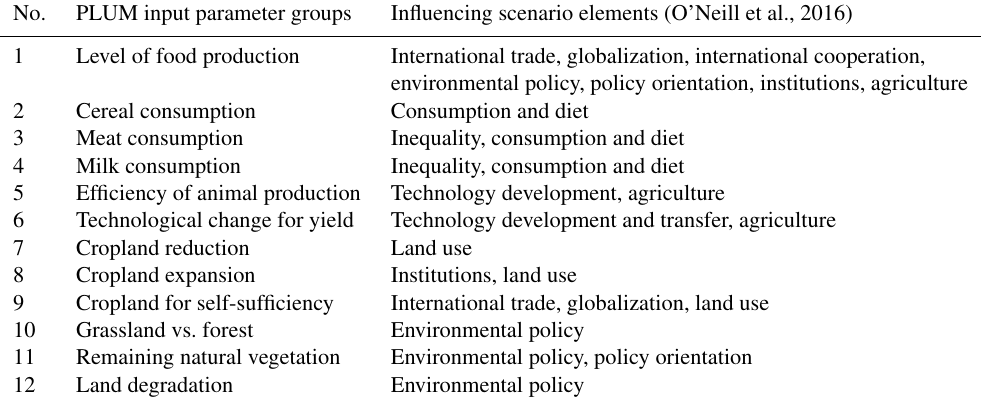
Table 2. PLUM input parameter groups and the influence of SSP scenario elements (from O’Neill et al., 2016). In PLUM several of the input parameters were grouped together conceptually, as indicated by the parameter group number (no.). For example, there are four input parameters that describe meat consumption trajectories of different income and cultural groups (meat1–meat4, see Table 1), which all belong to meat consumption, parameter group no.